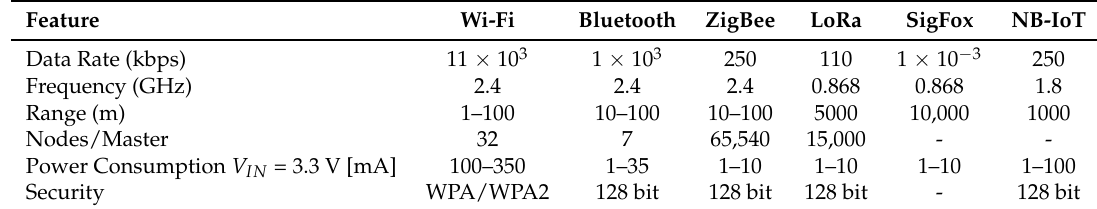
Table 3. Major Communication Wireless Protocols